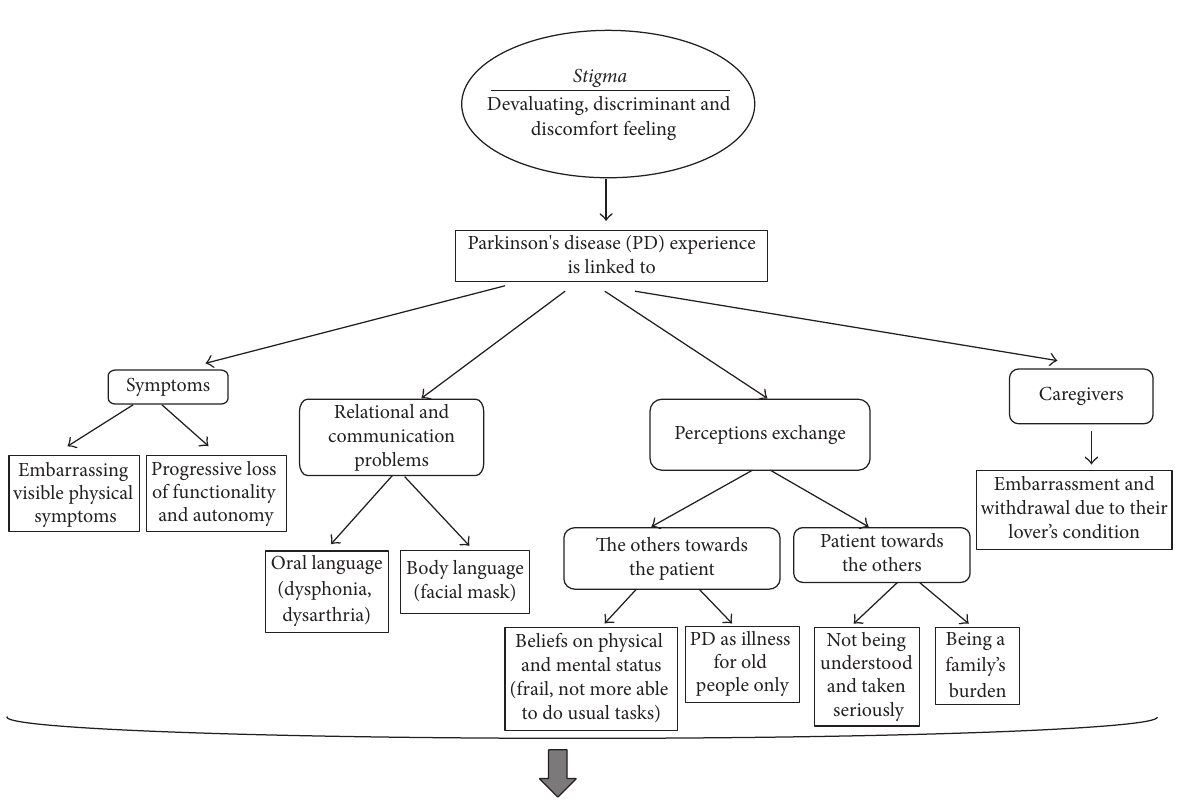
Figure 1: Stigma’s core constructs in Parkinson’s disease.